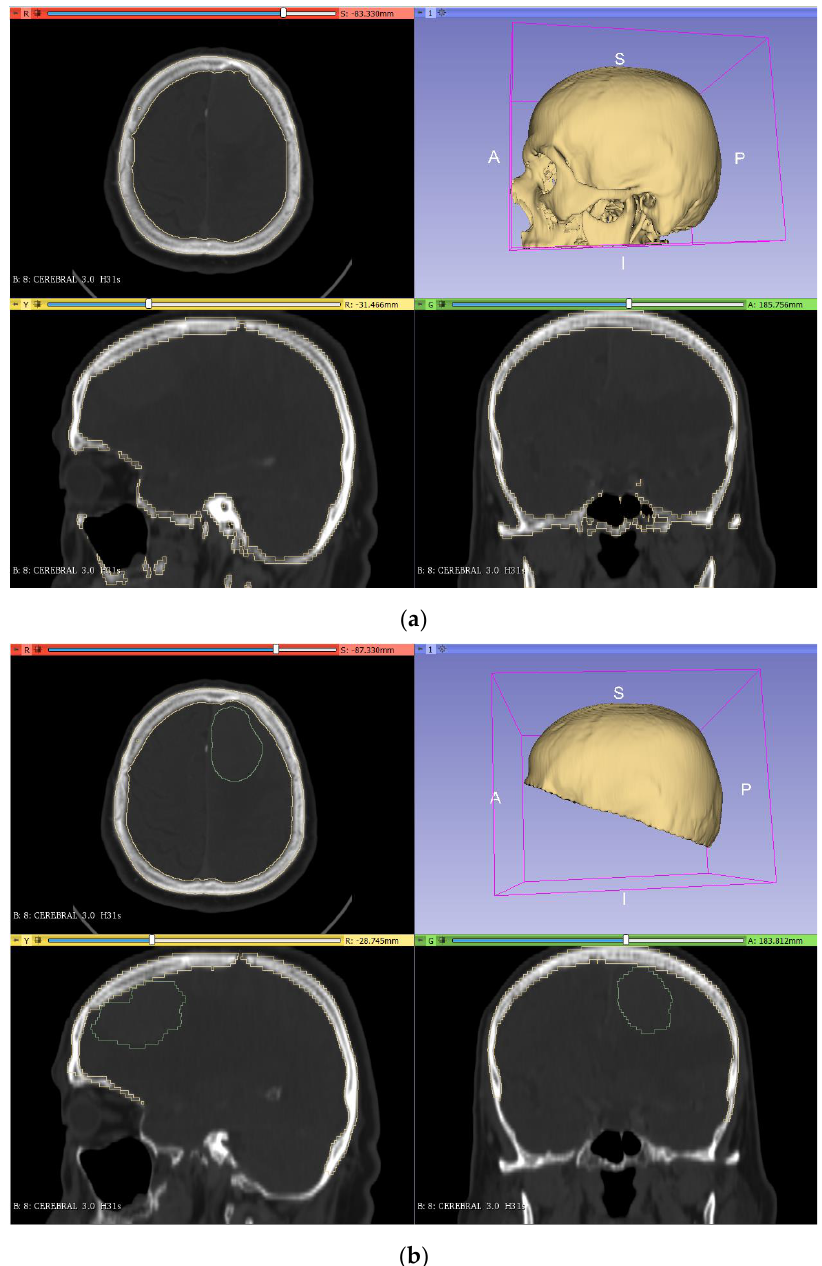
Figure 2. Segmentation ( a ) and cutting ( b ) of the skull model from the DICOM images in 3DSlicer.